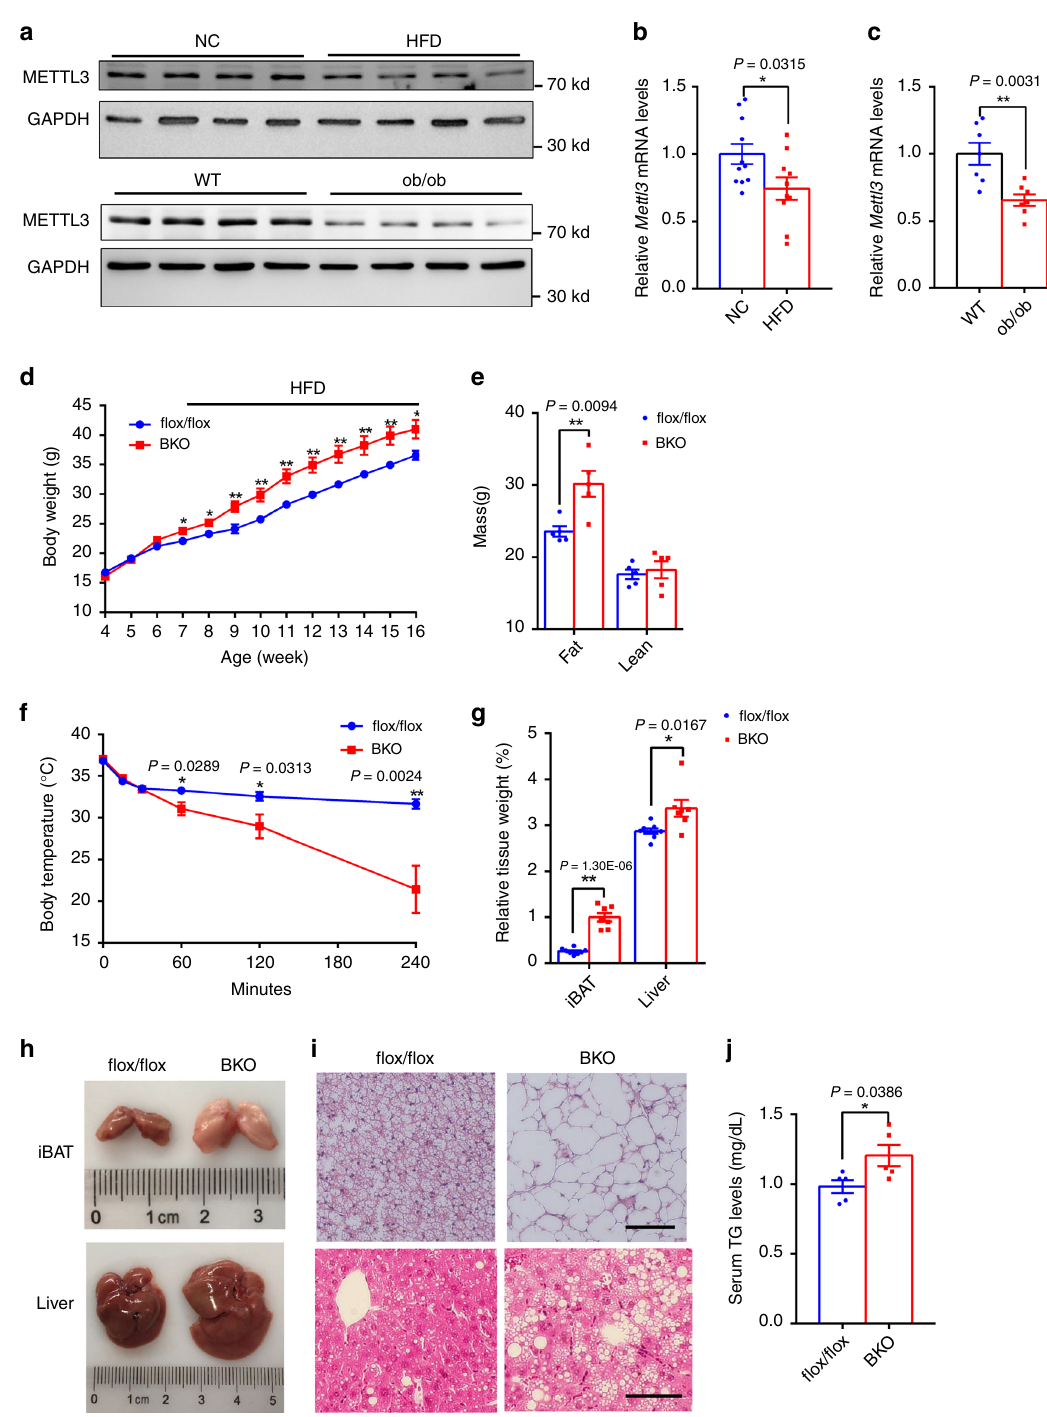
Fig. 8 BAT-speci fi c knockout of Mettl3 predisposes to HFD-induced obesity. a – c The METTL3 protein and mRNA levels in iBATs of HFD-fed mice, ob/ob mice and their respective control mice (NC, n = 11; HFD, n = 10; WT, n = 7; ob/ob, n = 7). d The growth curve of METTL3 BKO and Mettl3 fl ox/ fl ox mice fed HFD diet (5 weeks Mettl3 fl ox/ fl ox and BKO, n = 10 for each group; 6 weeks Mettl3 fl ox/ fl ox , n = 10; 6 weeks BKO, n = 12; 7 – 16 weeks Mettl3 fl ox/ fl ox and BKO, n = 12 for each group). e The fat and lean mass of 20-week-old HFD-fed mice ( n = 5 for each group). f The rectal temperature of HFD-fed Mettl3 fl ox/ fl ox and BKO mice during acute cold exposure (4 °C) ( Mettl3 fl ox/ fl ox , n = 6; 0, 60, 120 min BKO, n = 5; 240 min BKO, n = 4). g The relative tissue weight of iBAT and liver in 20-week-old HFD-fed mice ( Mettl3 fl ox/ fl ox , n = 8; BKO, n = 7). h Representative images of iBAT and liver from 20-week-old HFD-fed mice. i Hematoxylin and eosin (H&E) staining of iBAT and liver from 20-week-old HFD-fed mice. Scale bars represent 100 μ m. Three mice for each group were used for H&E staining with similar results. j The serum TG levels of 20-week-old HFD-fed mice ( n = 5 for each group). Data represent the mean ± SEM. Signi fi cance was determined by unpaired two-tailed Student ’ s t test analysis.* p < 0.05.** p < 0.01. Source data are provided as a Source Data fi